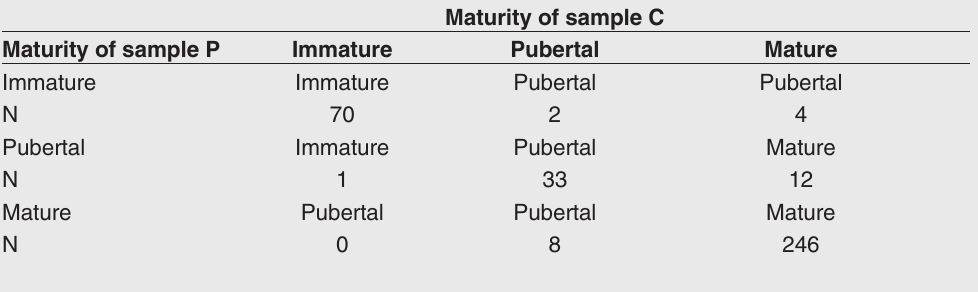
Table 1 . Assessment of maturity status of male harbour porpoises based on combinations of maturity assessments of peripheral (P) and central (C) testis tissue samples. The results of this classification are also indicated (N = number of animals of each